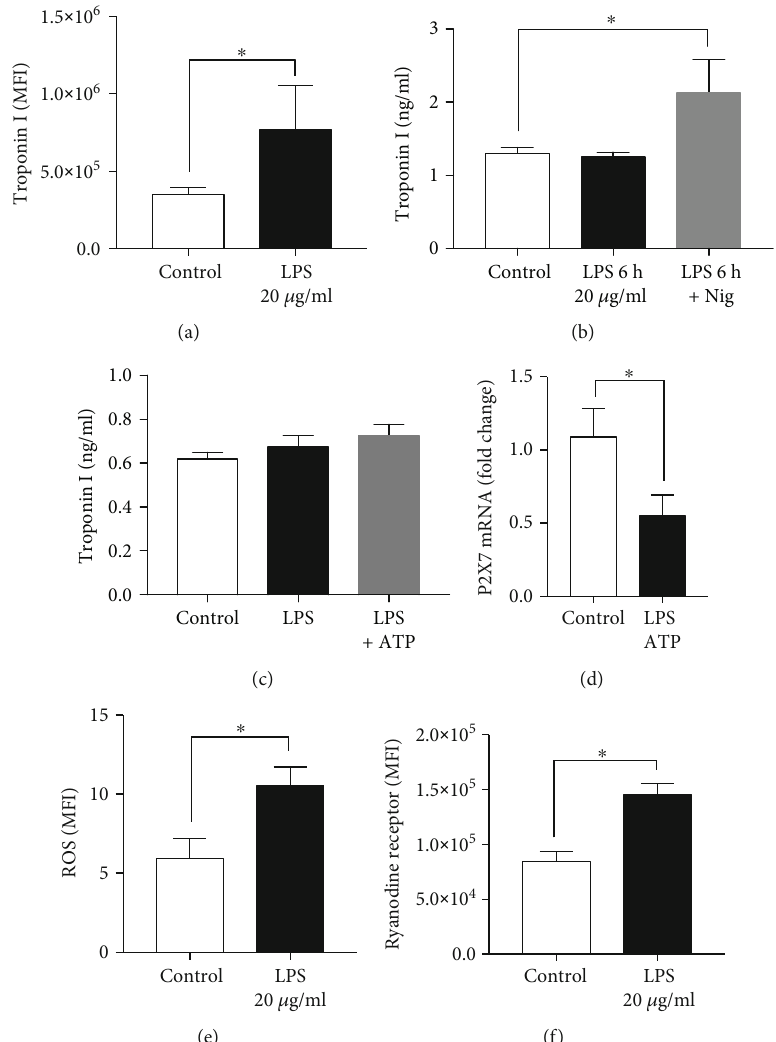
Figure 4: E ff ects of LPS on murine HL-cells. Fluorescence intensity of troponin I expression of HL-1 cells (a). Troponin I elevation in supernatant fl uids from HL-1 cells (b) and from human cardiomyocytes (c). mRNA expression of pyrogenic receptor (P2X7) in human cardiomyocytes (d). HL-1 cells were treated with 20 μ g/ml LPS and human cardiomyocytes (iPS) with 10 μ g/ml LPS for 6 h (black bars). Additional treatment included treatment with 20 μ g/ml or 10 μ g/ml LPS for 5 h, respectively, and for one further hour with either 1 mM ATP or 1 μ M nigericin (grey bars). Control groups were incubated in a cell culture medium without any supplements for 6h (white bars). Amount of cellular reactive oxygen species (ROS) (e). Fluorescence intensity of ryanodine receptor 1 (RyR1) (f). n = 6 per group; ∗ p < 0 : 05 . All values are expressed as mean ± SEM